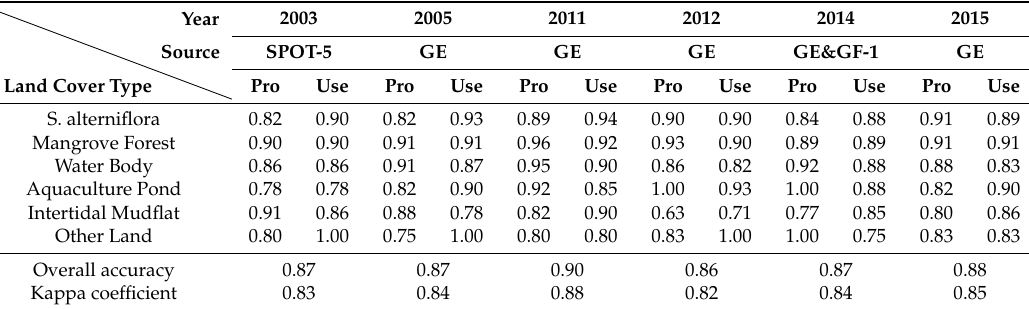
Table 2. Summary of land cover classification accuracies from 2003 to